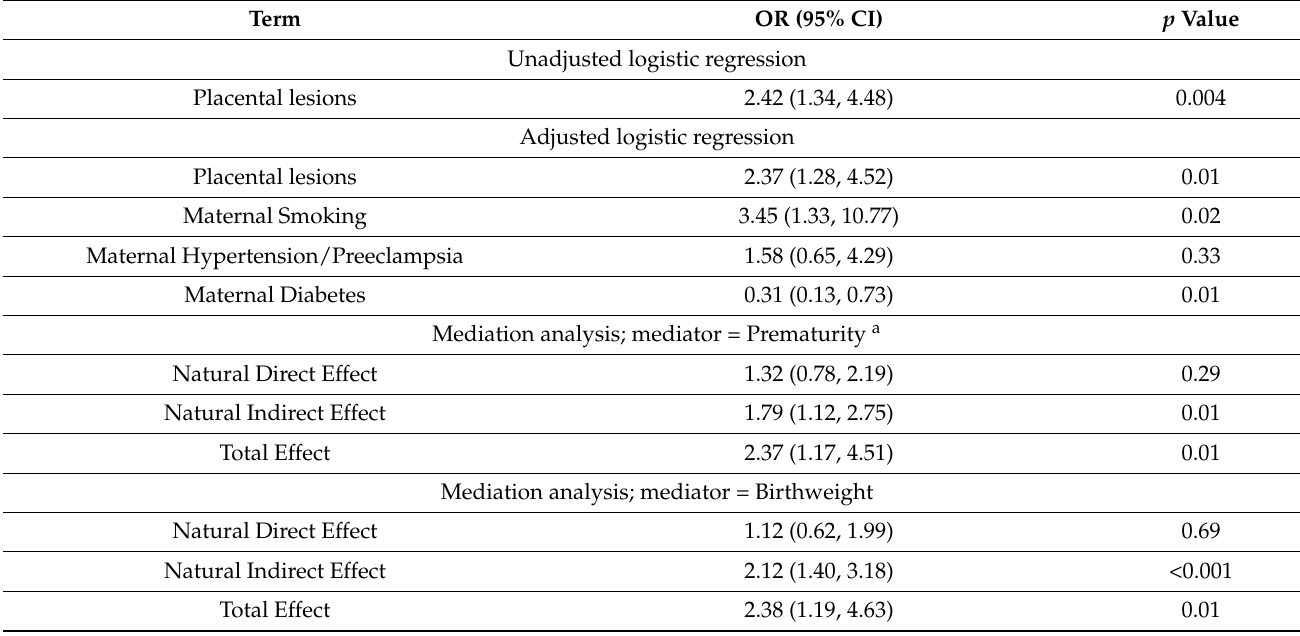
Table 2. Placental lesions and neonatal intensive care unit (NICU)